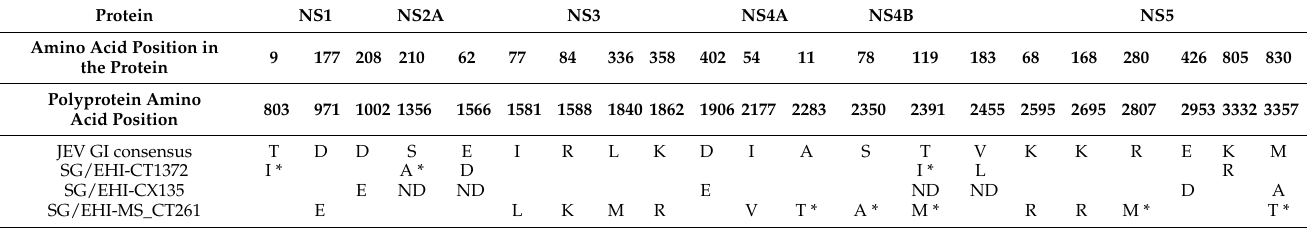
Table 7. Novel amino acid substitutions in the non-structural polyprotein of JEV genotype I. Substi- tutions only detected in the study sequences are shown. The comparison included all of the JEV GI complete coding sequences (n = 158) available in NCBI as of November 2022. Amino acid residues are numbered according to the complete polyprotein of NCBI Reference Sequence NP_059434.1. Dots indicate the residues that are identical to the consensus sequence. See Table S6 for the full list of substitutions in isolates included in the table and the undetermined amino acid residues of